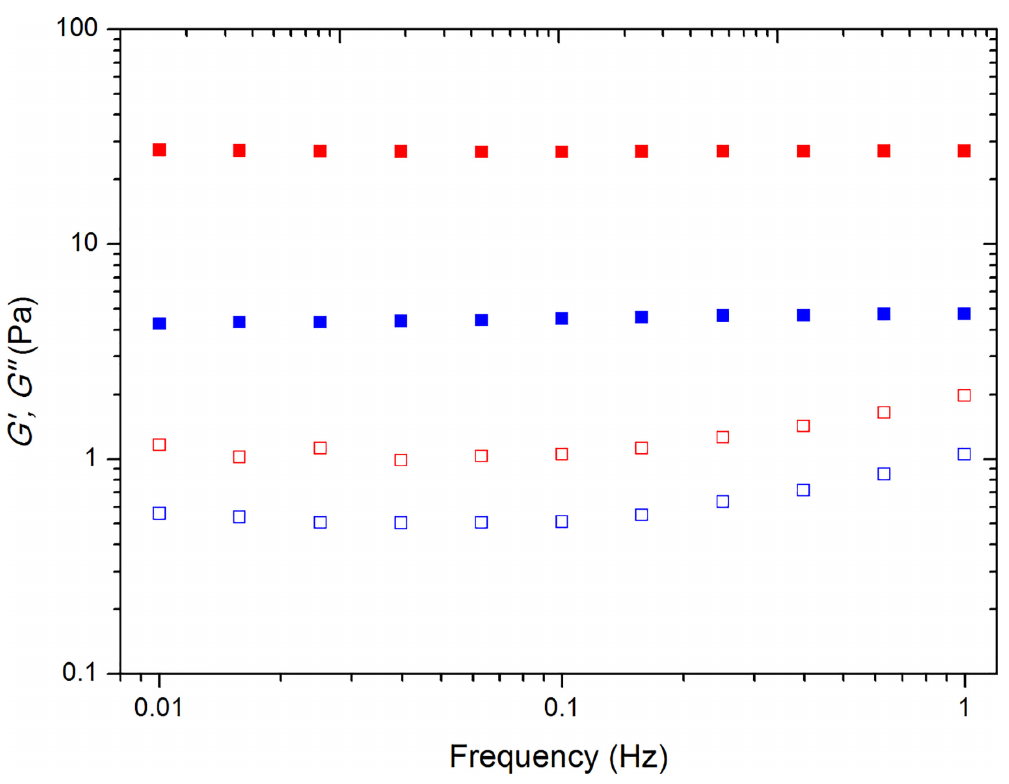
Fig 1. Storage modulus G ’ (solid symbols) and loss modulus G ” (open symbols) as a function of frequency. Symbols are Gelose 80 starch after HHP treatment (pressure releasing rate 100MPa/min) for 0 day storage (blue) and 30 days storage